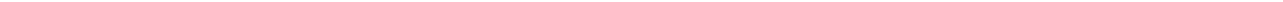
Fig. 2 STEF co-localises and interacts with Nesprin-2G and NMMIIB. a High-resolution confocal immuno fl uorescence images of parental U2OS cells co- stained for DNA (DAPI), STEF and Nesprin-2G, with an intensity look-up table (16-colours, ImageJ). b Fluorescence intensity pro fi le of STEF (black) and Nesprin-2G (red) signals across the nuclei of U2OS parental cells. Position of line scan indicated by the dashed white line in a . c The Duolink ® PLA assay was conducted in parental U2OS cells with the Duolink ® II red kit, and cells were imaged in the red fl uorescence channel. Immuno fl uorescence images of the fl uorescent signal obtained for single primary antibody controls (STEF only, Nesprin-2G only) and interaction between STEF and Nesprin-2G (STEF/ Nesprin-2G). d Quanti fi cation of Duolink ® signal from primary antibody controls and STEF-Nesprin-2G antibodies ( >100 cells per condition per replicate). Values represent the mean of three independent experiments. Statistical signi fi cance was veri fi ed using a one-way ANOVA, using Tukey ’ s multiple comparison test to compare the means of each sample. ** p < 0.01, *** p < 0.001. Error bars represent S.E.M. e Immuno fl uorescence images taken on the high-resolution confocal microscope of parental U2OS cells stained for DNA (DAPI), STEF and NMMIIB. White arrowheads indicate co-localisation between STEF and NNMIIB. f Co-immunoprecipitation (IP) of endogenous NMMIIB with endogenous STEF from parental U2OS cell lysates, compared to the IgG control. Representative western blot shown from four independent immunoprecipitation experiments. Scale bars = 10 µ m